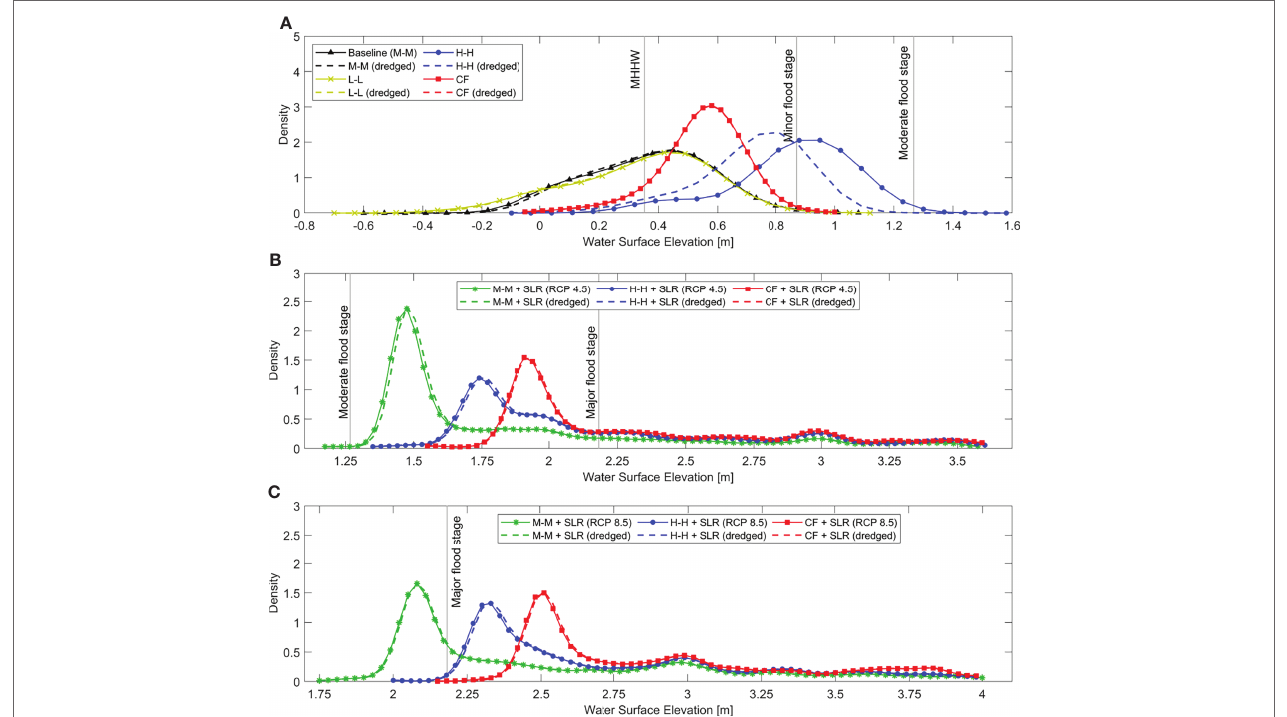
FIGURE 6 | Probability density functions (PDFs) of maximum water surface elevation (WSE) within wetland areas near the Mobile River, AL. The PDFs are constructed based on flood composites simulated with current bathymetry (solid line) and after channel dredging (dashed line). The scenarios consider water level regimes with (A) current mean sea level, and sea level rise projections under (B) RCP 4.5 (50 th percentile), and (C) RCP 8.5 (50 th percentile). Mean higher high water and flood stage thresholds are referenced with respect to NAVD88 and correspond to those of Mobile State Docks tide-gauge (NOAA station ID: